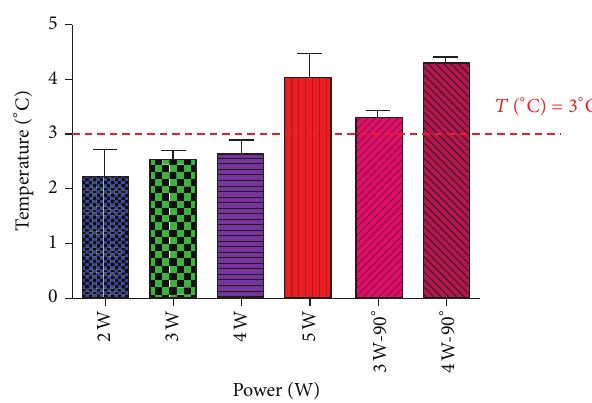
Figure 6: Pulp temperature rise during Nd:YAP laser irradiation of exposed dentine for tubular occlusion. The output powers ranging between 2W and 4 W used with a tangential incidence may be considered as harmless for the pulpal